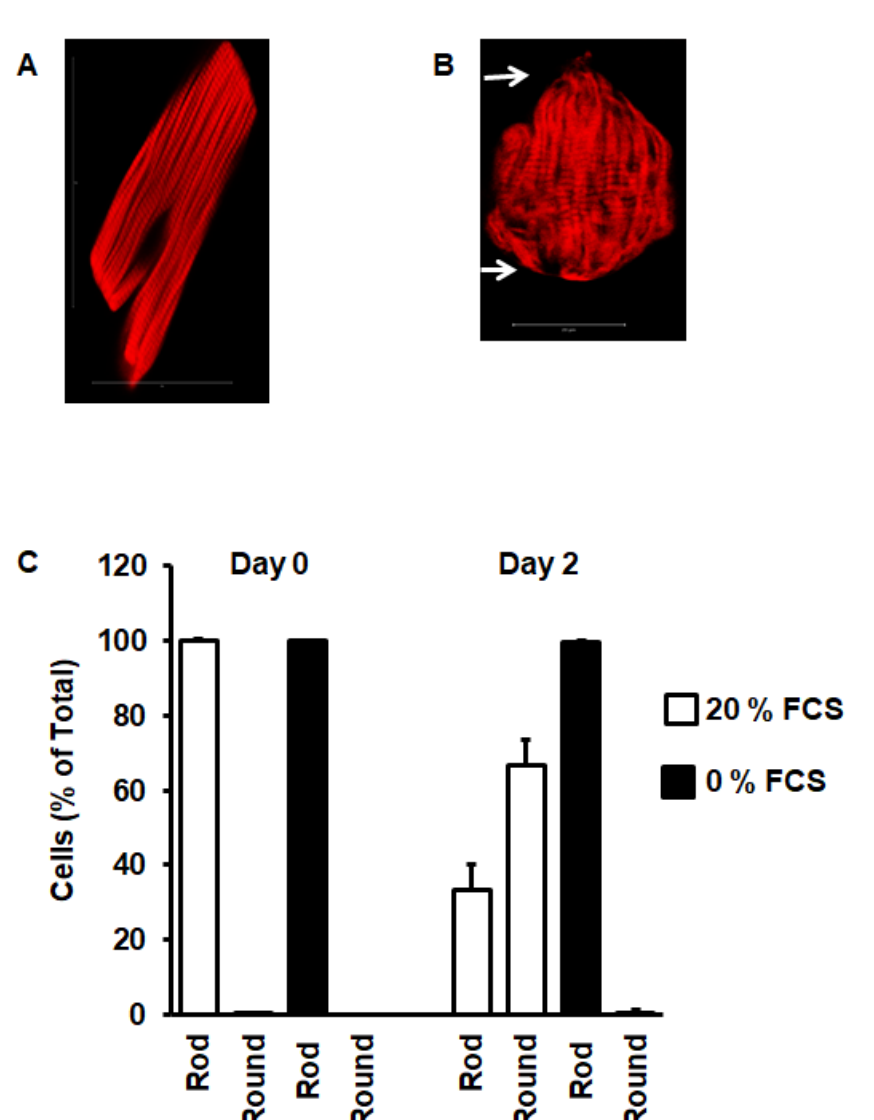
Figure 2. Cell rounding during cultivation. ( A ) Freshly isolated cardiomyocyte with phalloidin staining of actin to visualize striation of sarcomeres. ( B ) Cardiomyocytes after 48 h cultivation in the presence of fetal calf serum, indicating sarcomere degradation from the cell poles. ( C ) Quantification of the number of rod-shaped cardiomyocytes and round cardiomyocytes at start of cultivation (day 0) and at day 2. Data show the effect of serum on cell rounding. Data are means ± SD from n = 8 preparations (237–410 cells per preparation were analyzed).